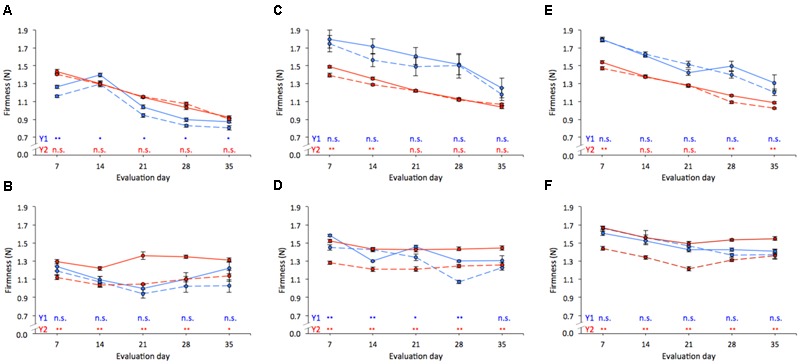
Firmness (N) changes during refrigerated storage [0°C and 85–88% relative humidity (RH)] of “Duke” (A,C,E) and “Brigitta” (B,D,F) blueberries, according to firmness segregation at harvest: soft (<1.60 N; A,B), medium (1.61–1.80 N; C,D), and firm (1.81–2.00 N; E,F). Assessments were taken during 2011/2012 and 2012/2013 (Y1, Y2; blue and red lines, respectively) on dropped (32 cm, dashed lines) and non-dropped (0 cm, solid lines) fruit. Each value represents the mean of five replicates of 20 fruit. Significance: n.s. (non-significant), ∗p < 0.05, ∗∗p < 0.01.